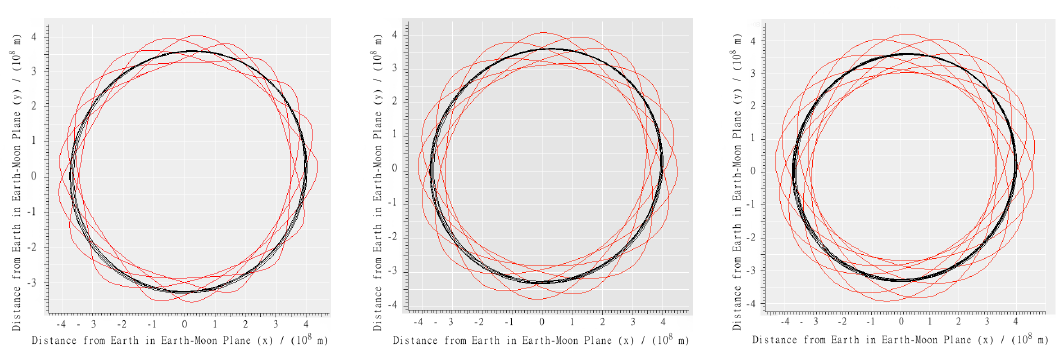
Figure 9. The 5:14:19 (3.8) (left); 6:11:17 (2.83) (center); and 8:9:17 (2.12) (right) resonances. In each plot, the black line (circular trajectory) represents the lunar orbit, and the red line (complex pattern) the DRO. Notice the peak altitudes increase as the ratio